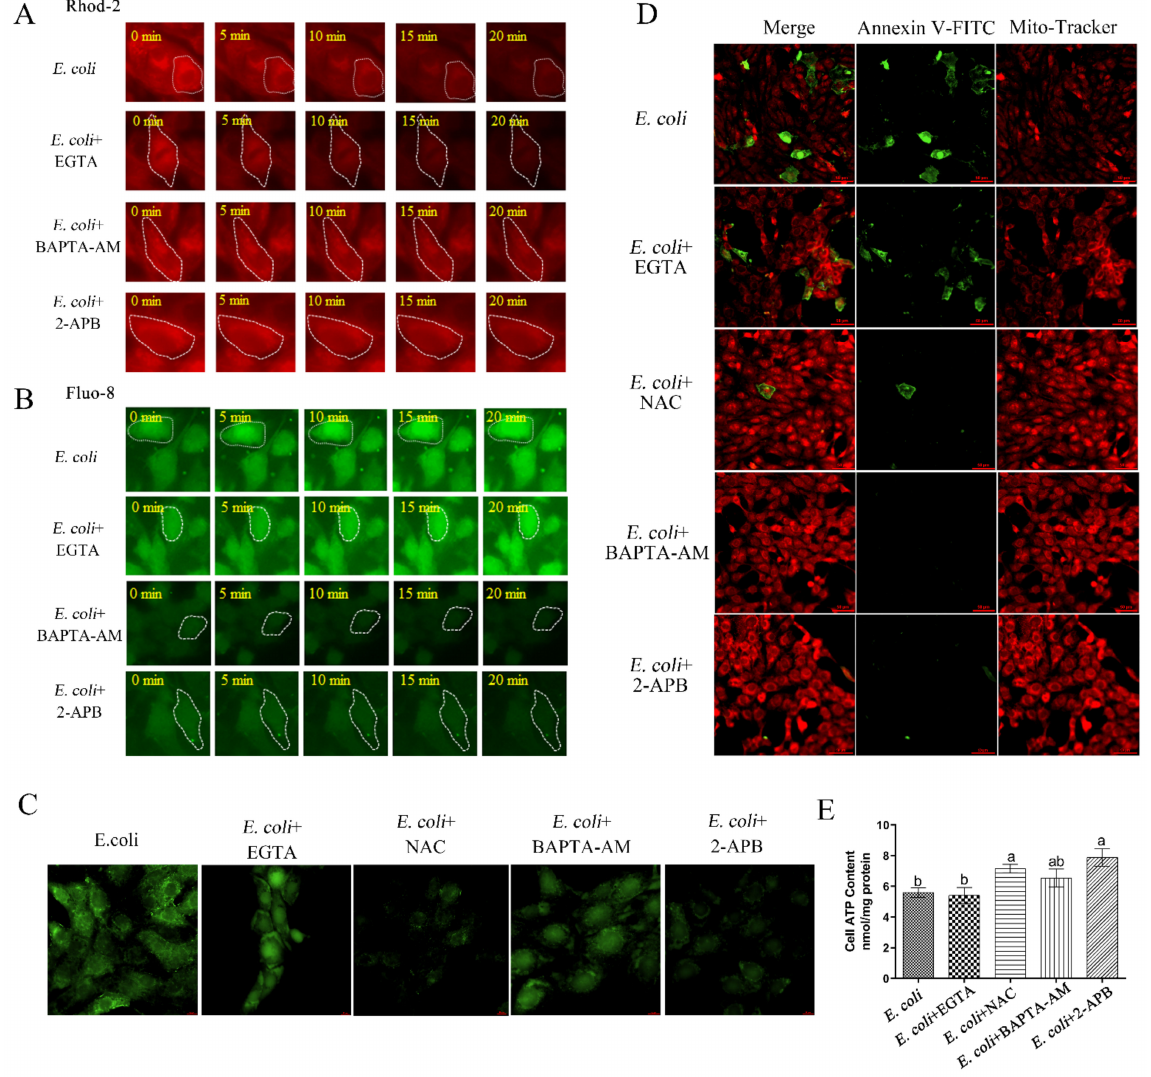
Figure 3. The role of cytoplasmic Ca 2+ in mitochondrial function. Primary bEECs were pre-treated with EGTA (5 mM), BAPTA-AM (10 µ M), 2-APB (50 µ M), or NAC (8 mM) before E. coli infection. EGTA is a Ca 2+ chelator that captures extracellular Ca 2+ . BAPTA-AM is a selective, permeable free Ca 2+ chelator that sequesters cytoplasmic Ca 2+ . 2-APB inhibits IP3 receptors and blocks release of calcium from store-operated calcium channels. The anti-oxidant properties of NAC are thought to combat some of the effects of oxidative stress. ( A ) Live-cell imaging was used to monitor mitochon- drial Ca 2+ levels. ( B ) Fluo-8 AM was used to monitor cytosolic Ca 2+ levels in real time. Cells were infected with E. coli for up to 20 min. ( C ) ROS levels were detected by DCFH-DA fluorescence after 6 h of infection. Scale bars = 10 µ m. ( D ) Cells were exposed to E. coli for 6 h and Mito-Tracker Red CMXRos was used to monitor membrane potential. Scale bars = 50 µ m. ( E ) Cellular ATP content was detected by an ATP assay kit after infection for 6 h. The data are means ± SEM of three independent experiments. Bars with different letters indicate significant differences ( p <